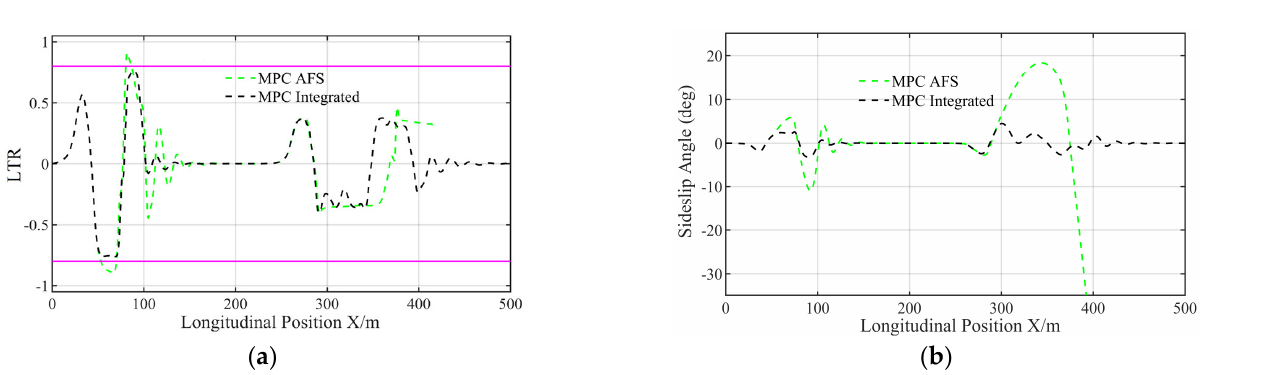
Figure 11. Comparison of ( a ) lateral LTR and ( b ) sideslip angle of the centroid at lower speed ( V x = 80km/h ).